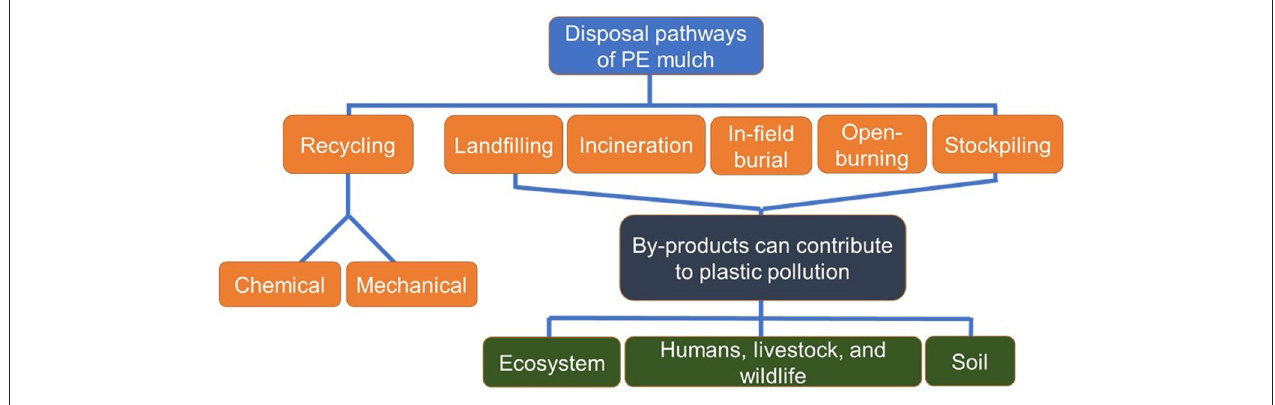
FIGURE 4 | Current end-of-life pathways of used plastic agricultural mulch in the United States (photo image by Brenda